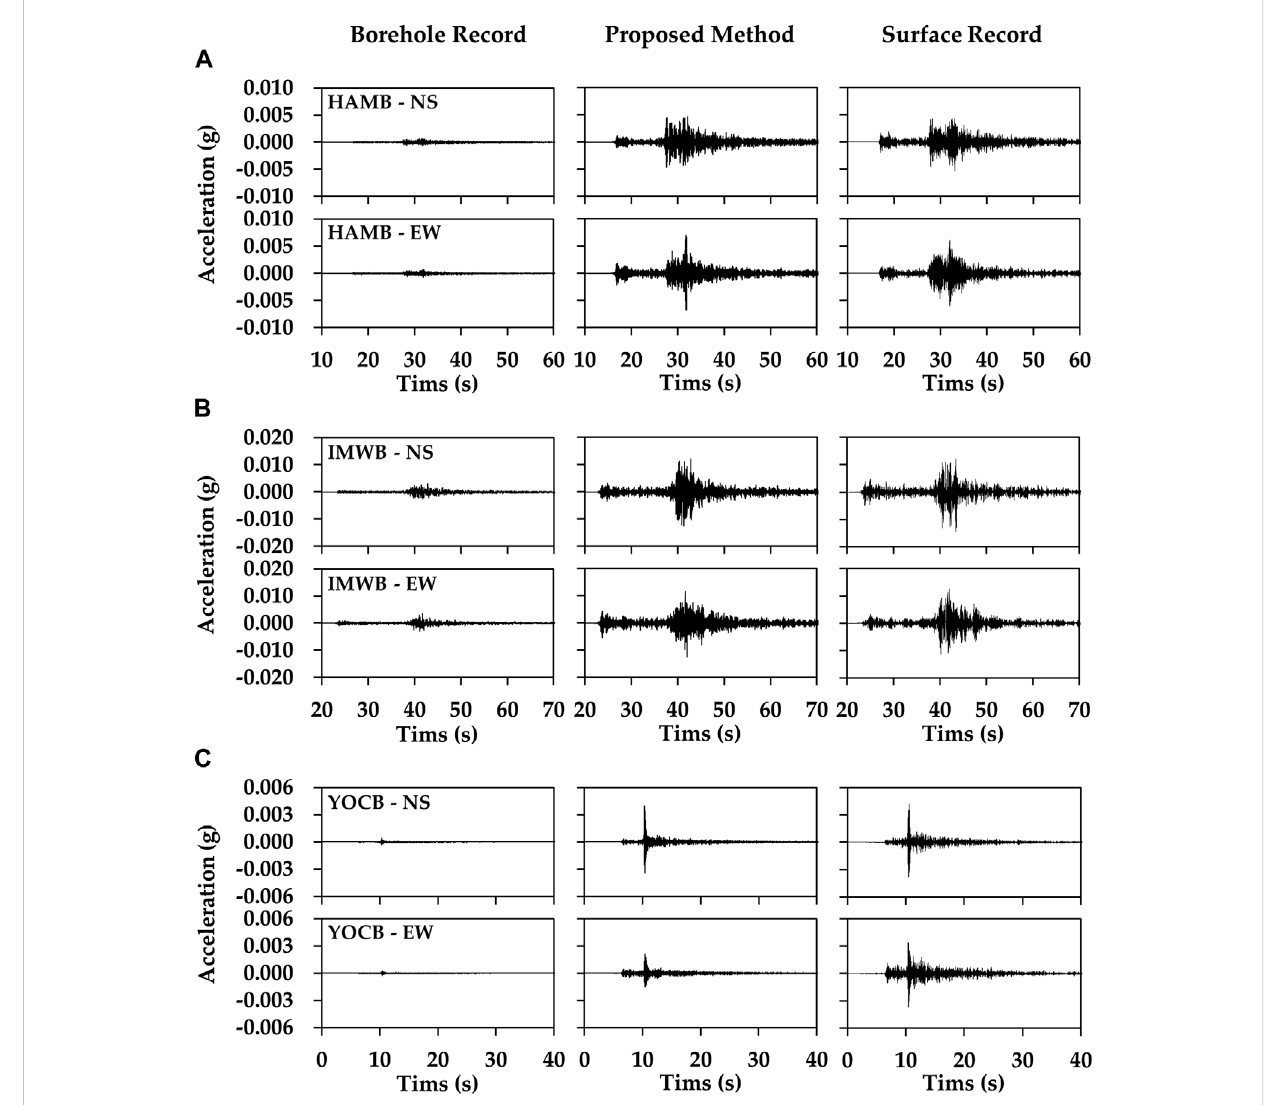
Comparison of surface records with proposed model for stations (A) HAMB, (B) IMWB, and (C) YOCB.